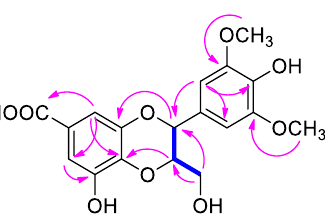
Figure 2. Key 1 H- 1 H COSY (blue lines) and key HMBC (heteronuclear multiple-bond correlation spectroscopy) (pink arrows) for compound 1 .